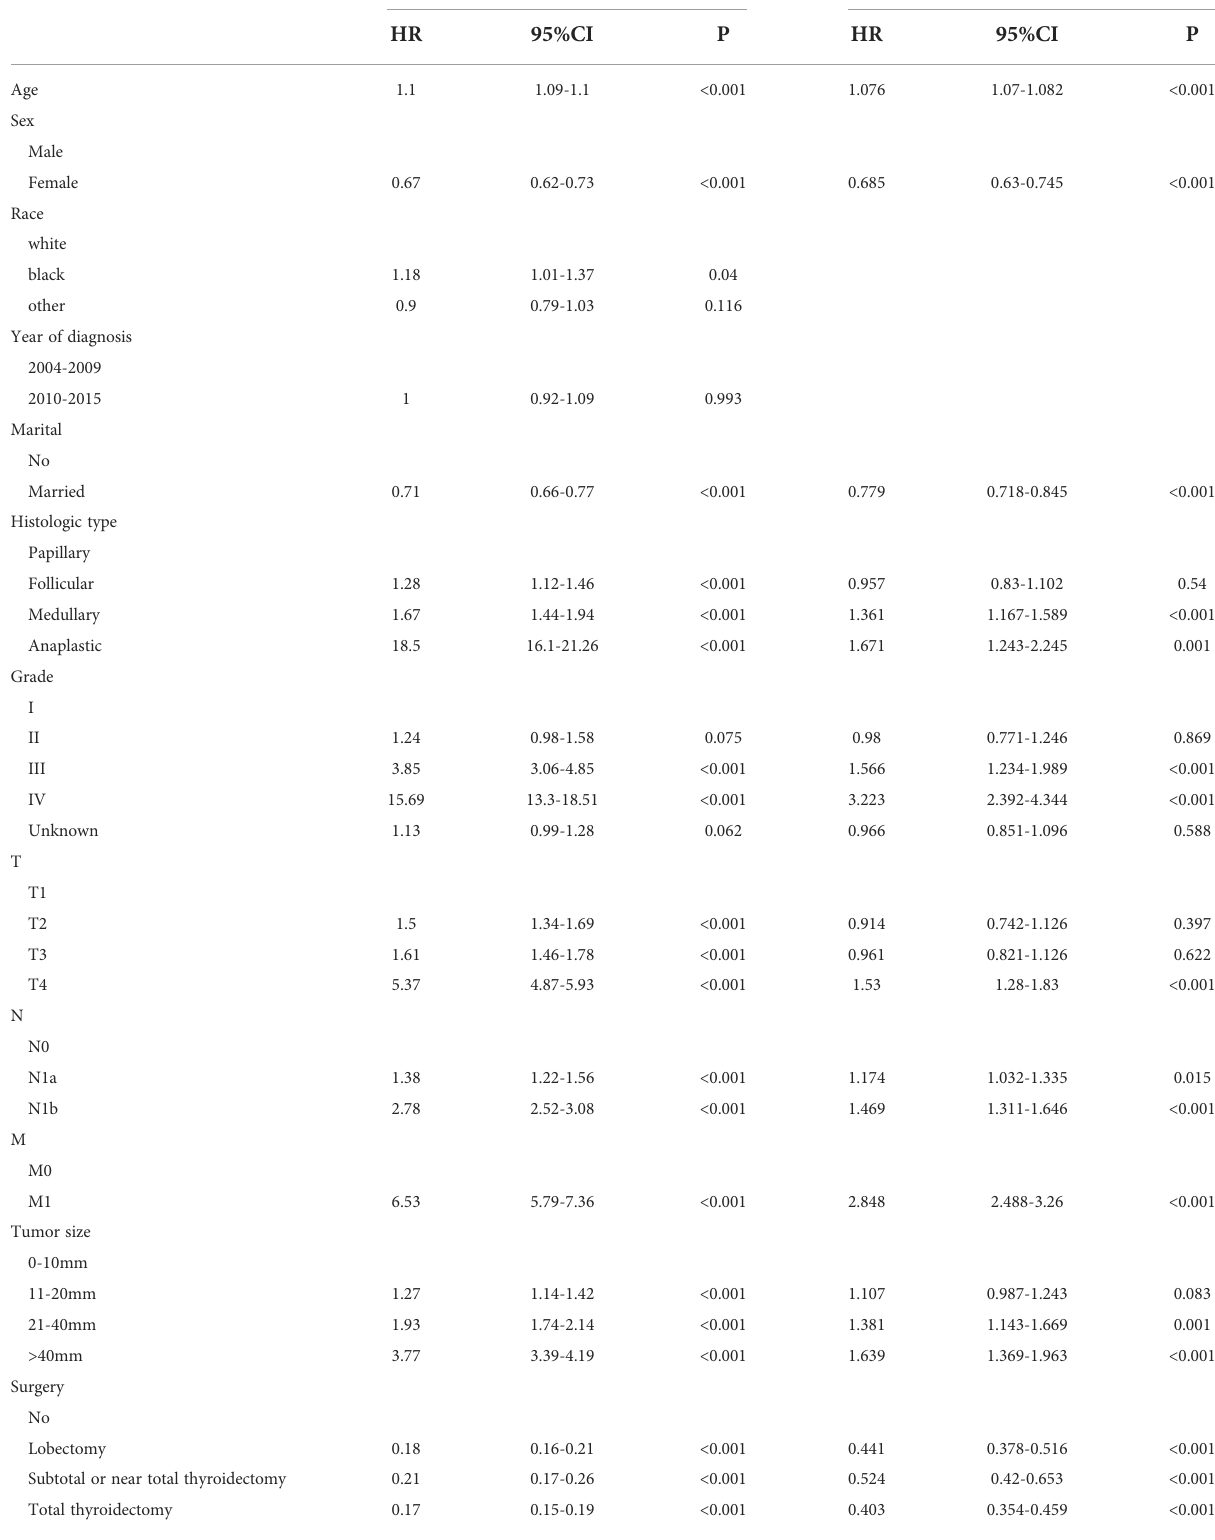
TABLE 2 Univariate and multivariate analyses of OS in training